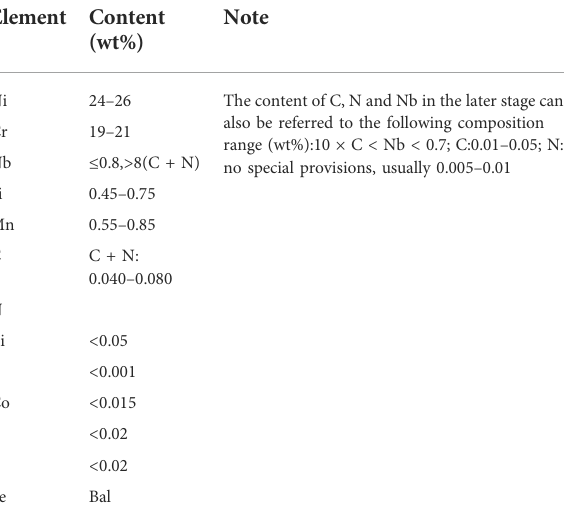
TABLE 1 Range of main elements of 20Cr25NiNb for AGR cladding (Norris et al., 1992; Evans and Donaldson, 1998). Element Content